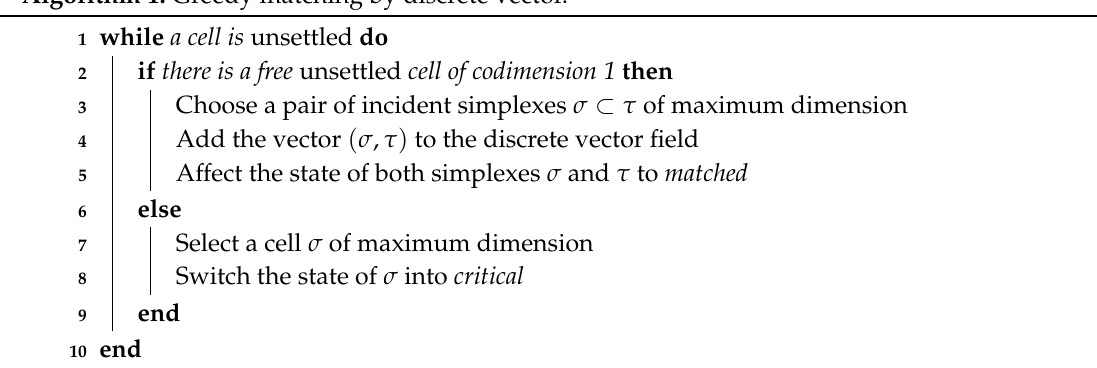
Algorithm 1: Greedy matching by discrete